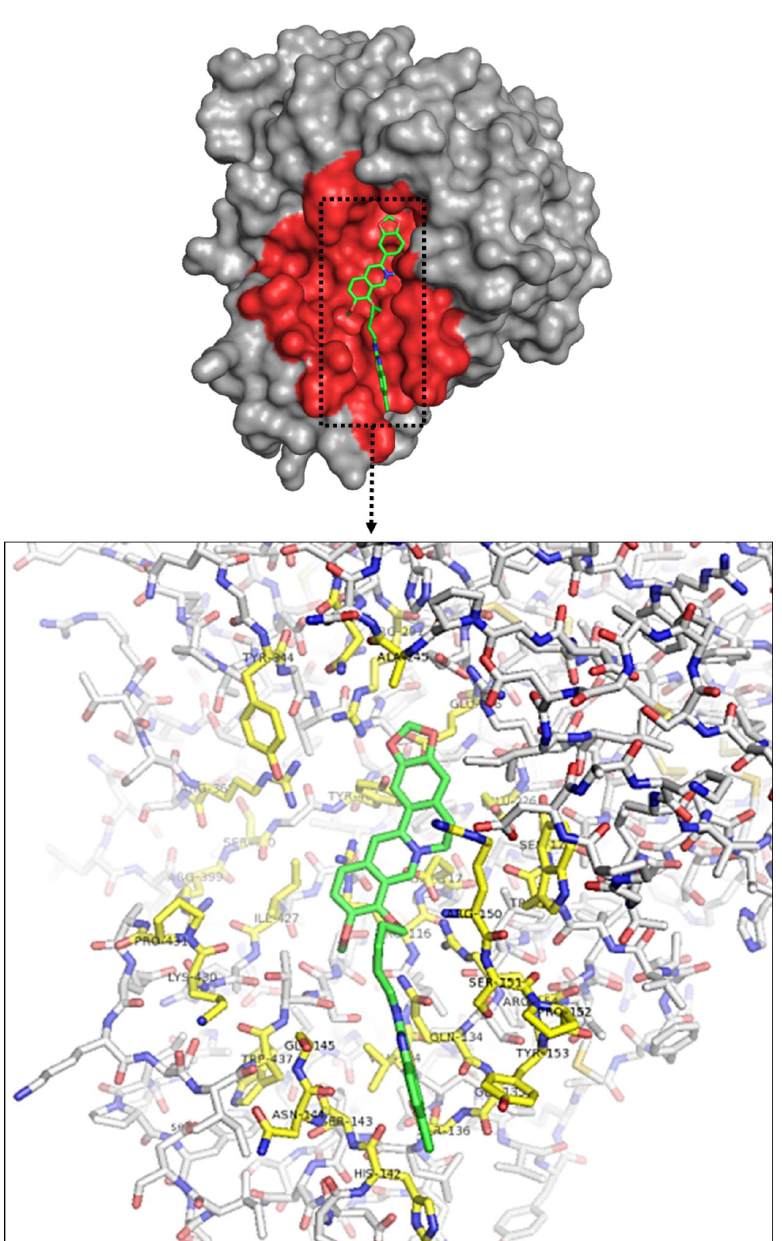
Figure 2. Crystal structure of influenza NA glycoprotein subunit docked with BBD-7. Pocked and important residues of influenza NA glycoprotein subunit colored as pink.